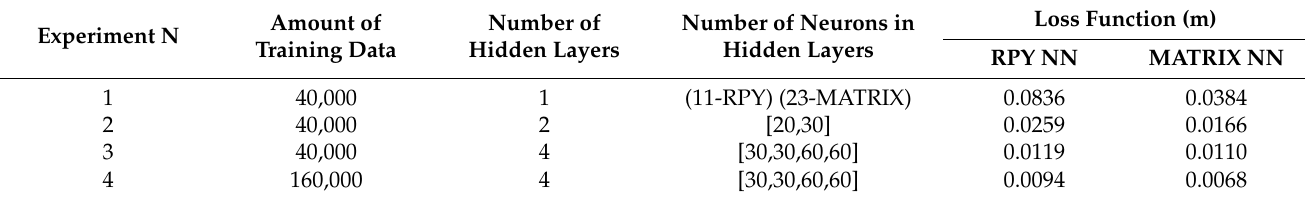
Table 4. Results of training neural networks.